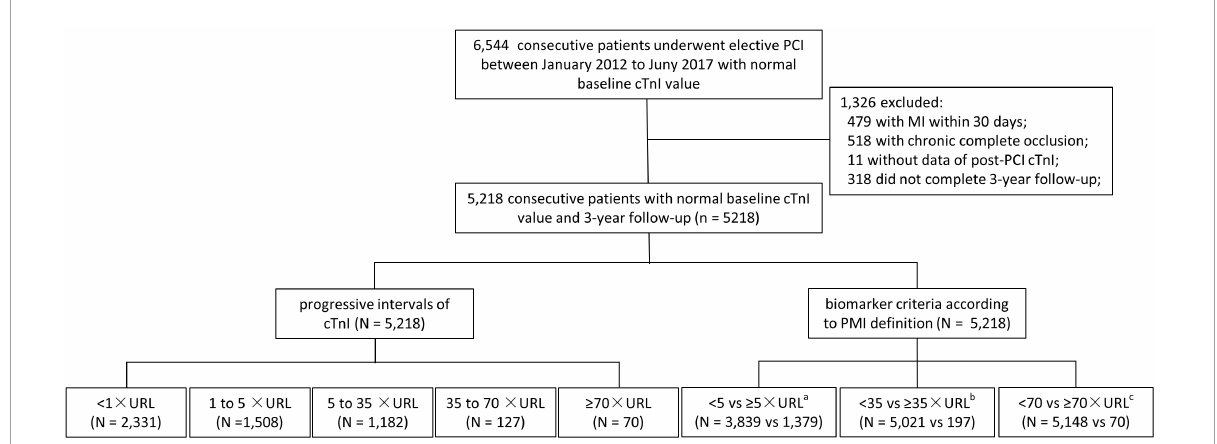
FIGURE1 Study flowchart. From January 2012 to July 2017, 6,544 consecutive patients underwent PCI with normal baseline cTnI value. After excluding 11 patients with baseline increased or missing post-PCI cTnI values, 479 within 30-day MI, 518 with chronic complete occlusion, and 318 patients who were lost to follow-up, 5,218 consecutive patients with 3-year follow were finally included in this analysis. cTnI, cardiac troponin I; MI, myocardial infarction; PCI, percutaneous coronary intervention; URL, upper reference limit. a According to biomarker criteria of PMI defined by third and fourth universal definition of myocardial infarction criteria; b according to biomarker criteria of PMI defined by Academic Research Consortium-2; c according to biomarker criteria of PMI defined by the Society for Cardiovascular Angiography and